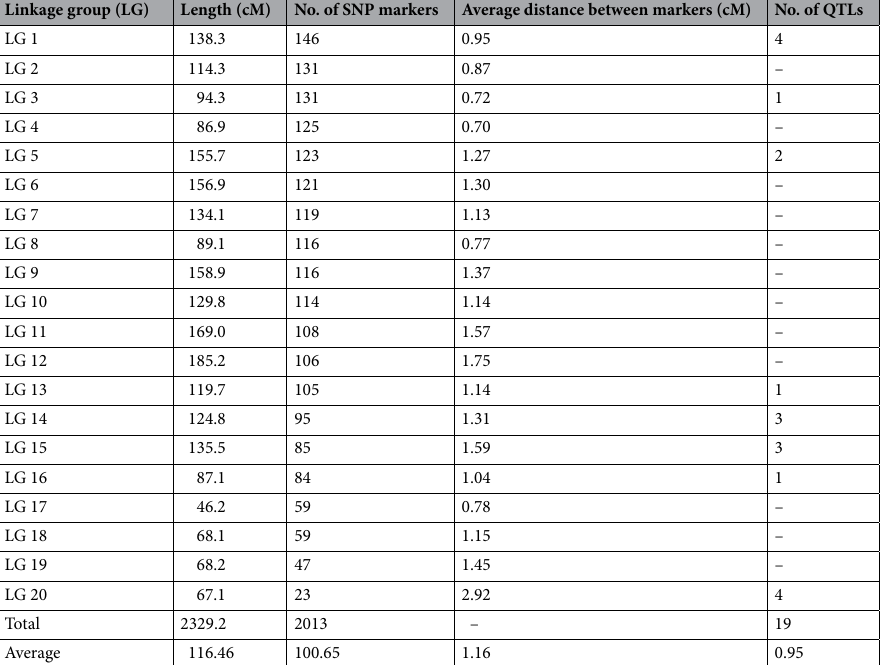
Table 1. Summary of high-density SNP marker distribution on linkage groups in bitter gourd cross DBGy- 201 × Pusa Do